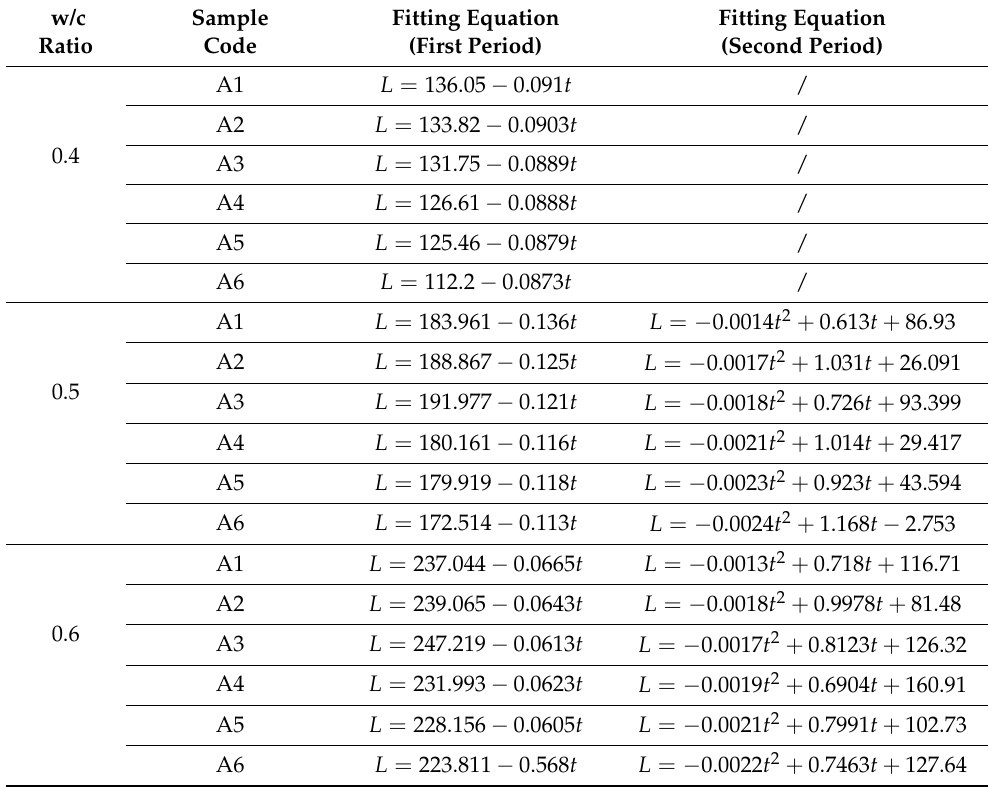
Table 5. Flow spread–time equations of cement paste containing